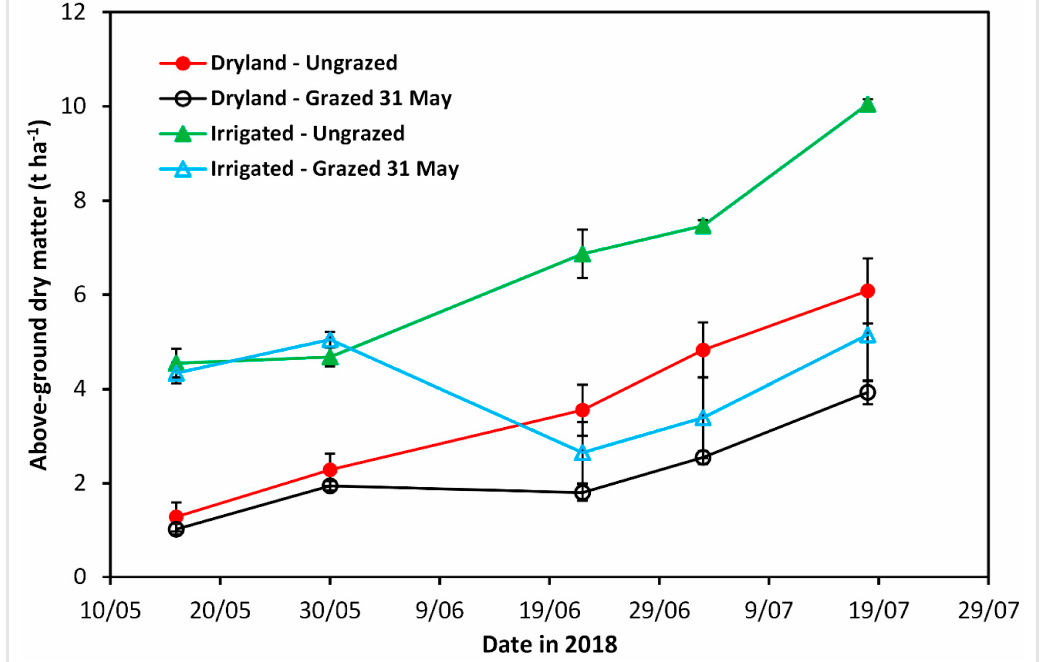
Figure 4. Above-ground dry matter of unirrigated and irrigated treatments after the first grazing (31 May). Indicated are also standard error